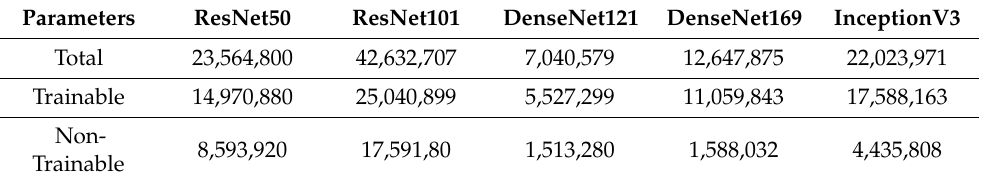
Table 2. The total parameters of each model along with the trainable and non-trainable parameters after unfreezing some